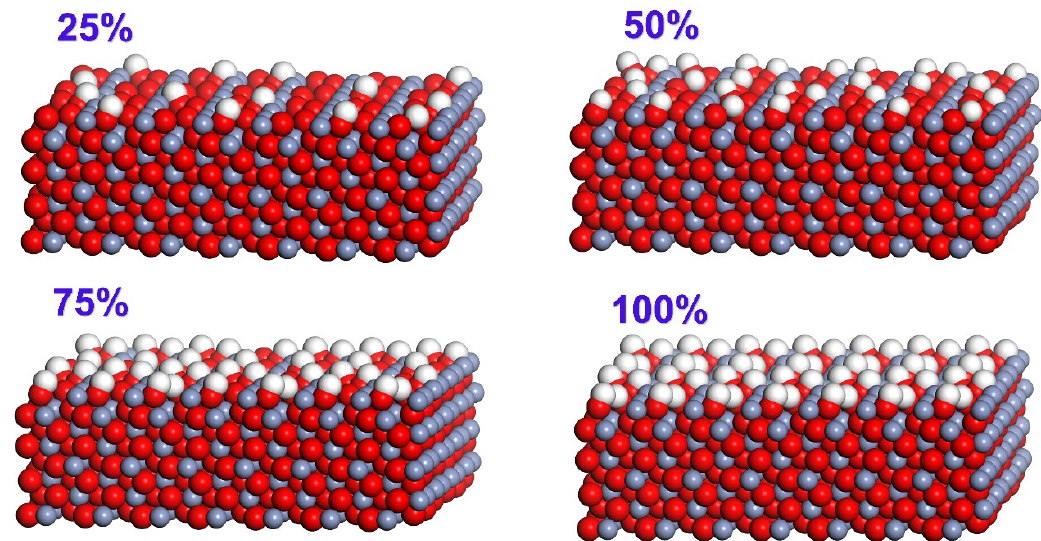
Figure 16. Cr 2 O 3 (200) surface with different hydroxyl concentration (white is H atom, red is O atom, gray is C atom).